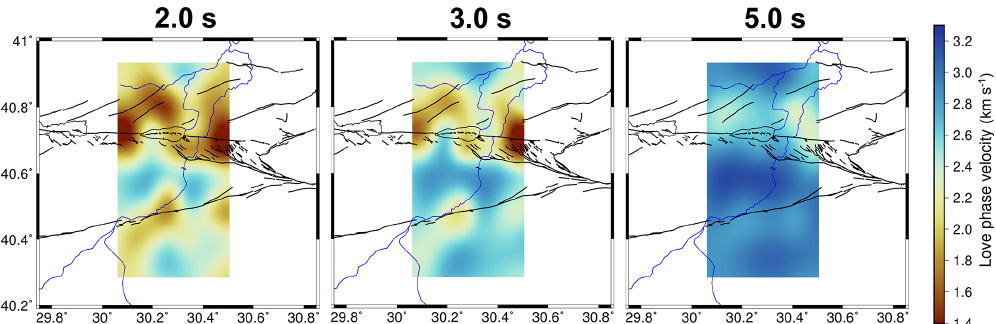
Figure 4. Love wave phase velocity maps at 2.0, 3.0 and 5.0s periods. Black lines show the mapped faults. The blue line represents the Sakarya River flowing towards the